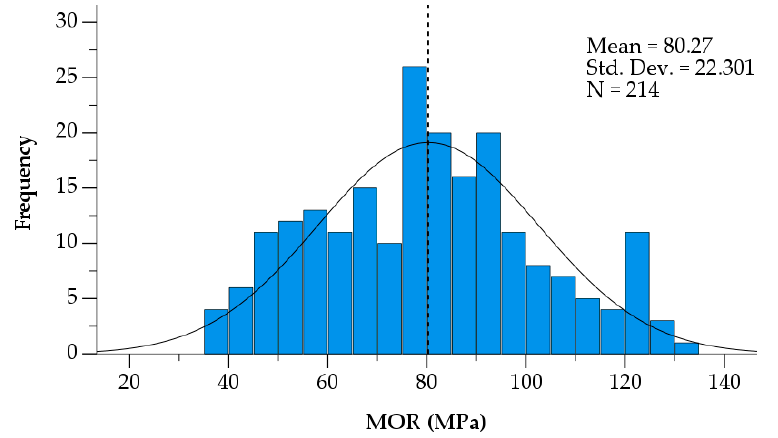
Figure 5. Histogram of MOR of solid timber specimens from the outer layers of E. nitens CLT for a population of 214 specimens.